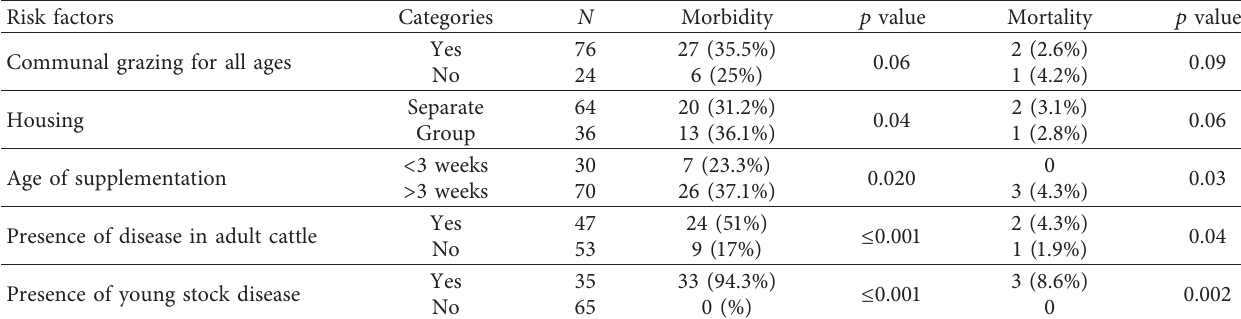
Table 4: Effect of management risk factors on morbidity and mortality of calves.